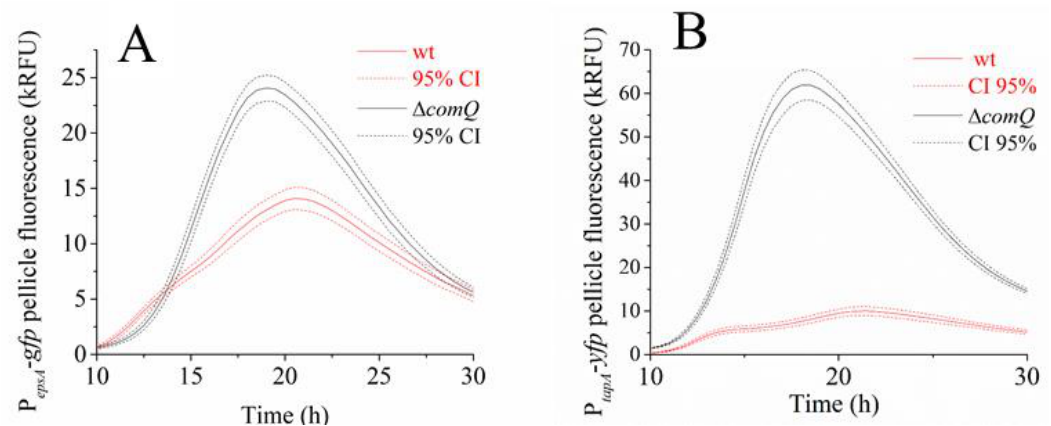
Figure 2. Bulk pellicle biofilm fluorescence measured in a microplate reader in B. subtilis PS-216 during static growth in MSgg medium at 37 °C. ( A ) Pellicle biofilm fluorescence intensity of the wild type phenotype P epsA - gfp reporter (wt; BM1631) strain and the Δ comQ mutant phenotype (BM1622) reporter strains. ( B ) Pellicle biofilm fluorescence intensity of the P tapA - yfp wild type phenotype (wt;